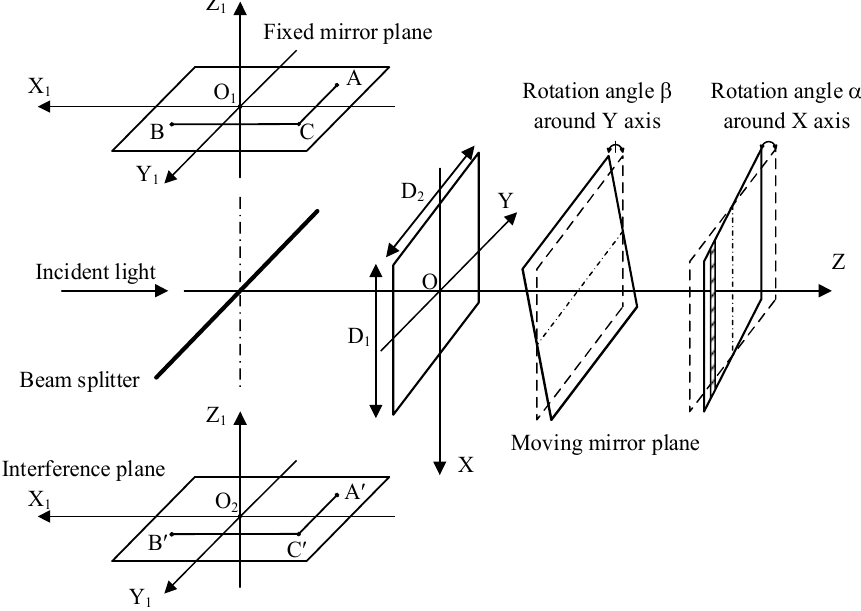
Figure 3. Structures of a fixed mirror and moving mirror in the interferometer. When the tilt angles α and β are nonzero at the same time, the optical path of the light source arriving at the interference plane changes, leading to the change in modulation.